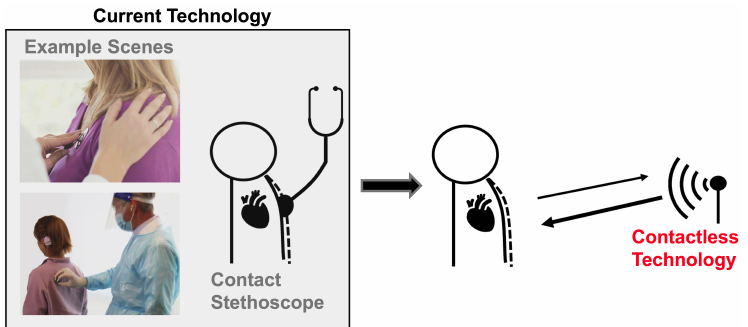
Figure 1. Current heart sound monitoring requires practitioners to attach a device onto a patient. Radar-based heart sound measurement provides an alternative measurement method that can be collected at a safe social distance, improving patient and a practitioner experience and permitting continuous